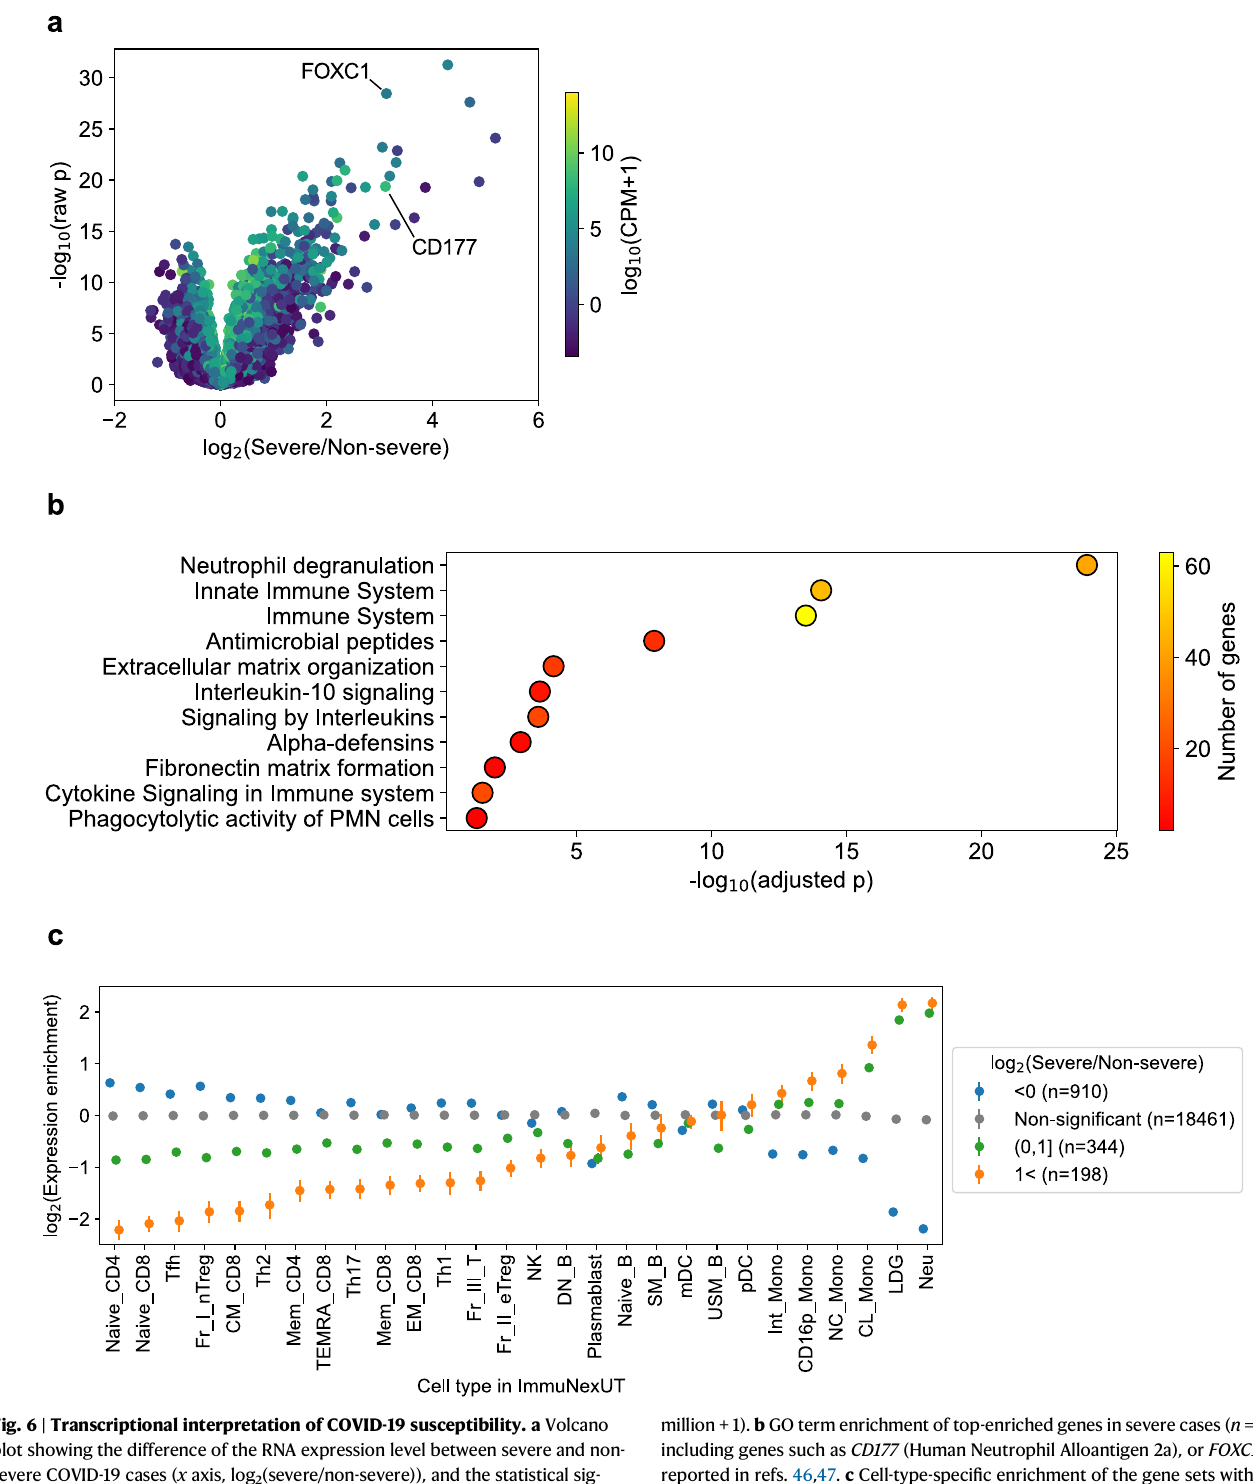
million+1). b GO termenrichmentof top-enriched genesinseverecases ( n =198), including genes such as CD177 (Human Neutrophil Alloantigen 2a), or FOXC1 as reported in refs. 46,47. c Cell-type-speci fi c enrichment of the gene sets with dif- ferent levels of differential expression, for 28 cell types from